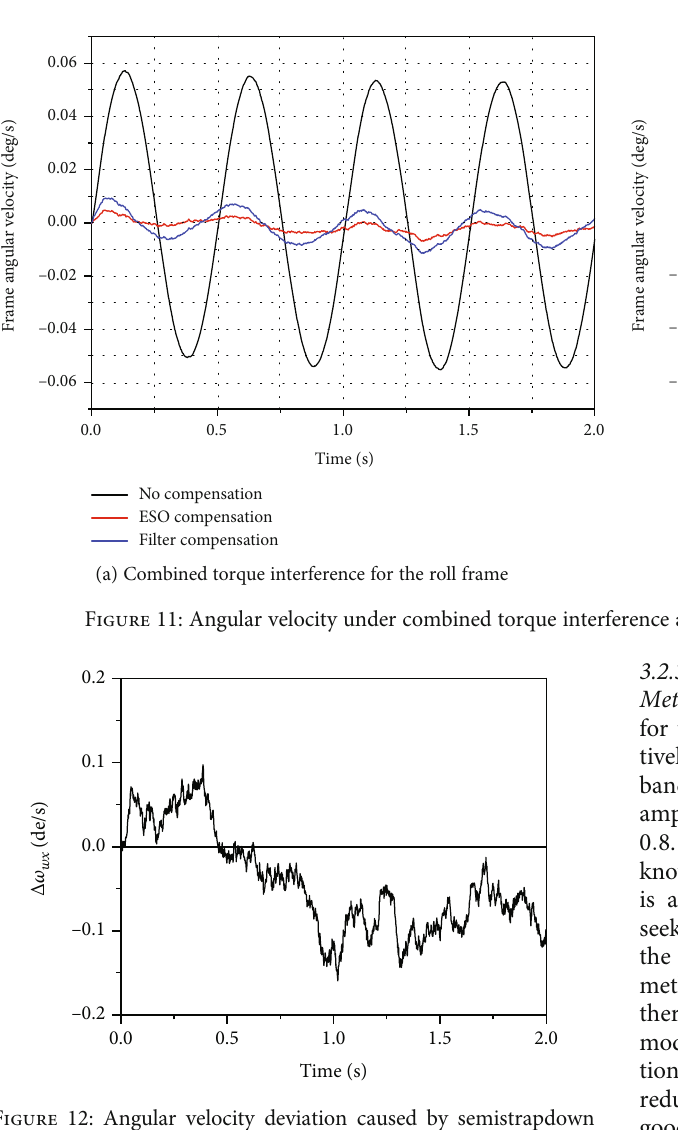
Figure 12: Angular velocity deviation caused by semistrapdown